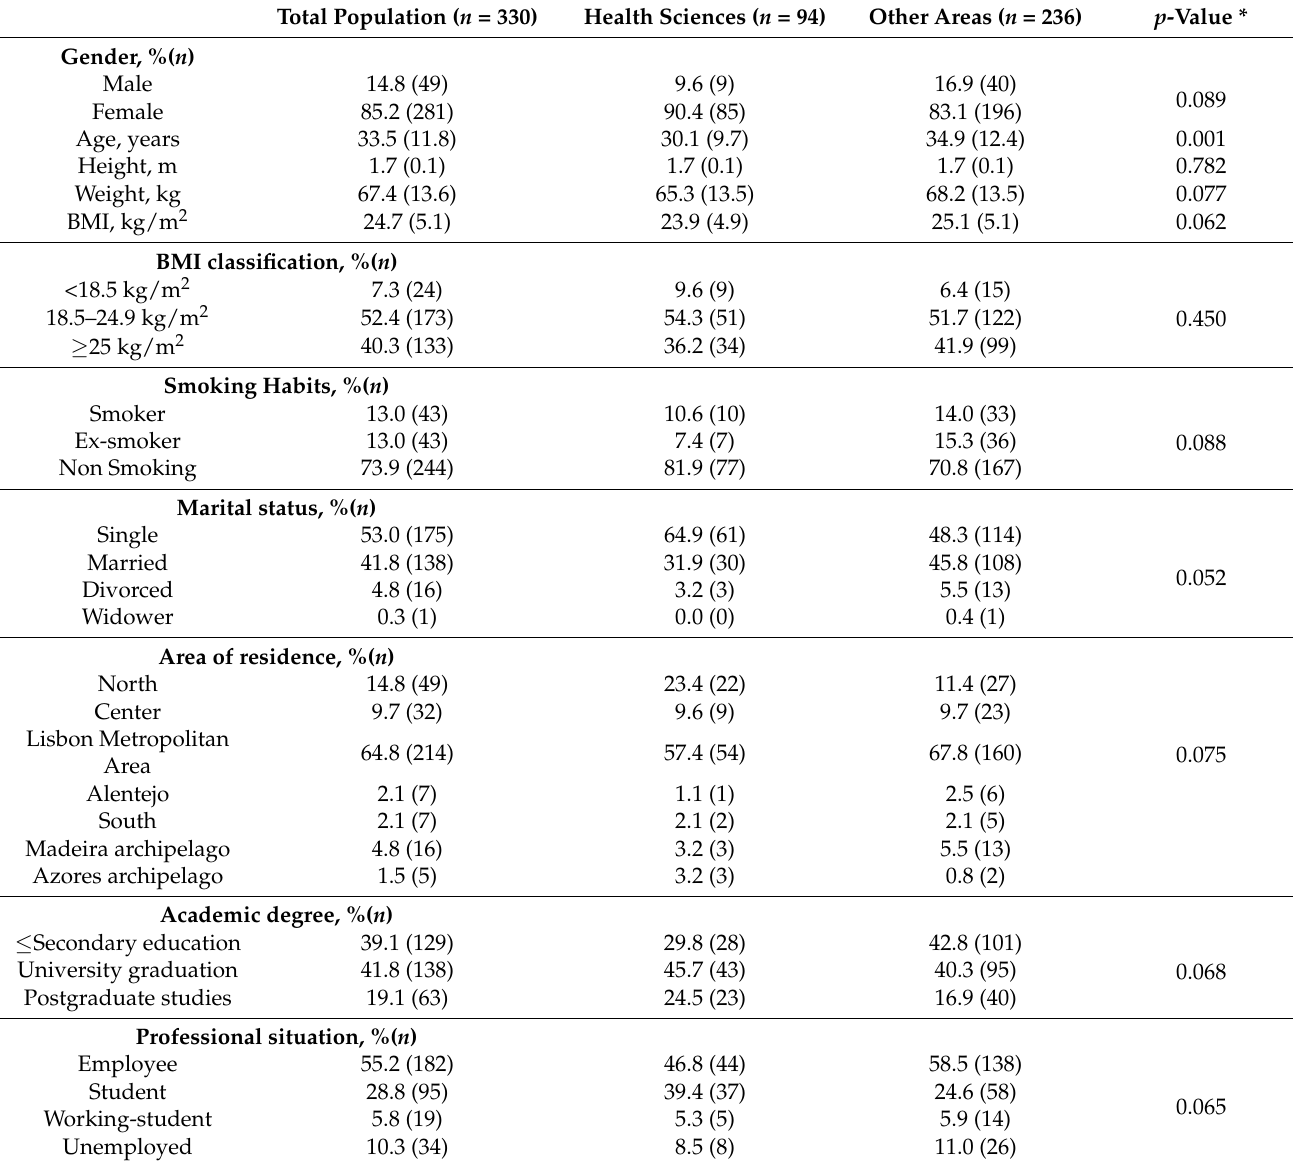
Table 1. General characteristics of the studied population categorized by professional area.